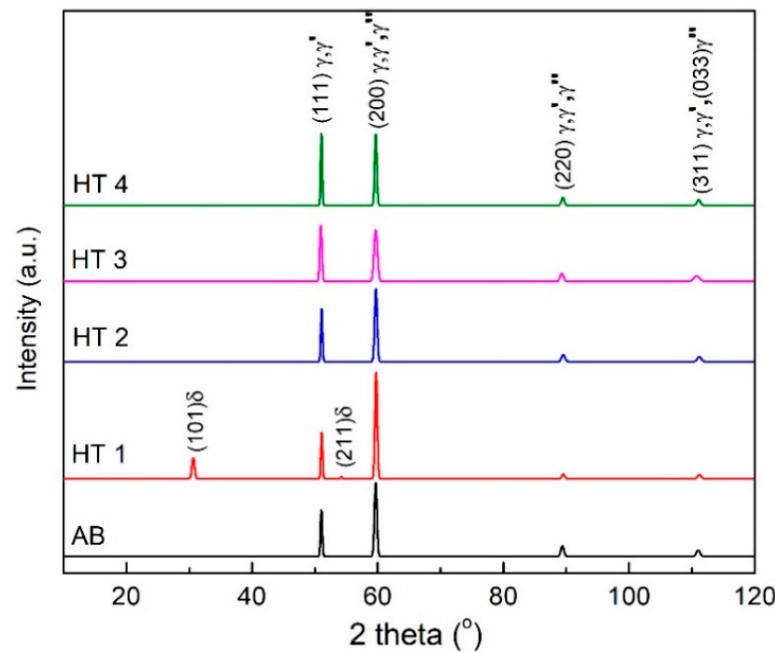
Figure 12. XRD diffraction patterns of the IN718 specimens in AB and HT conditions.